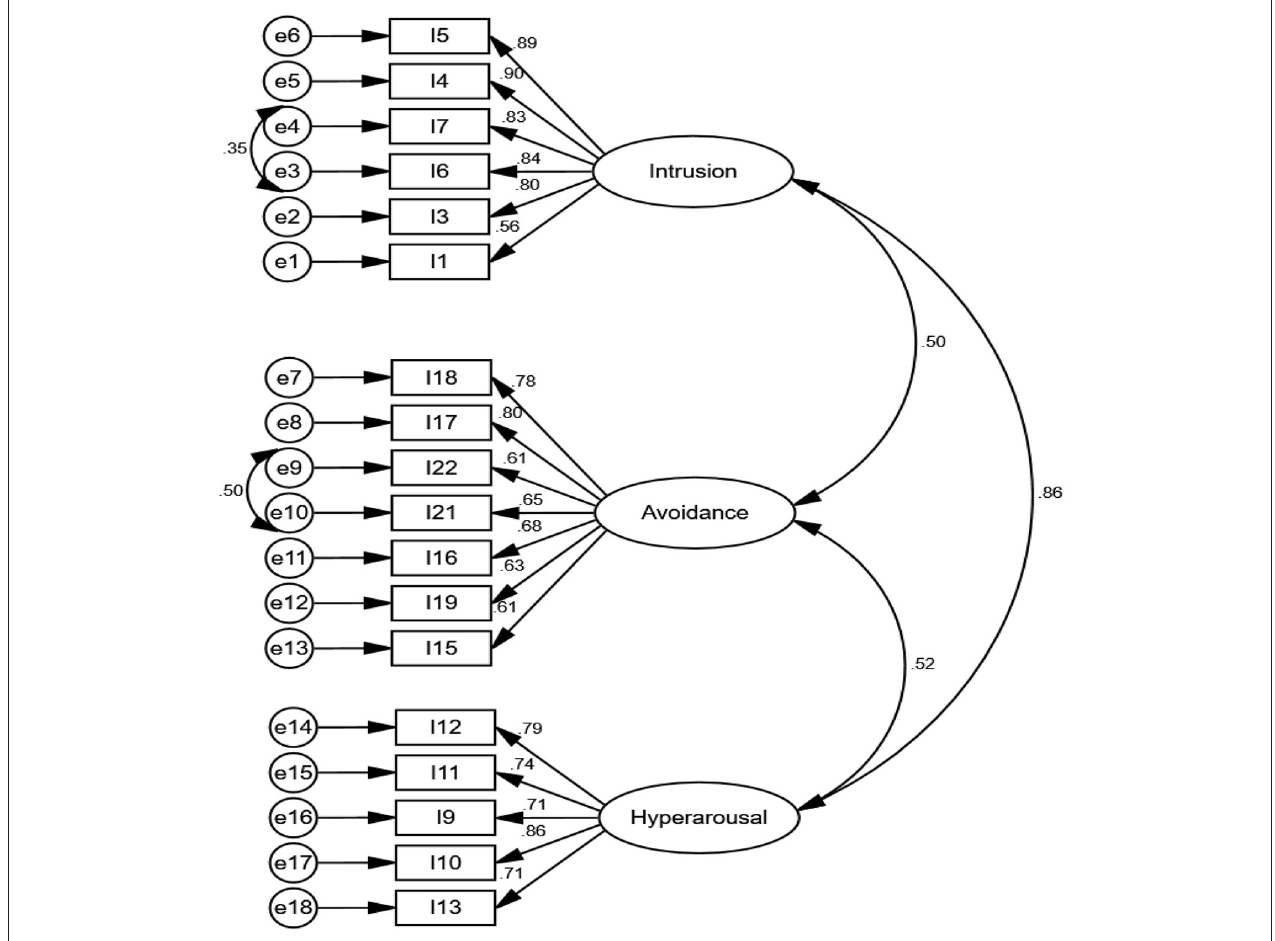
FIGURE 3 | First—order CFA of IES-R ( n